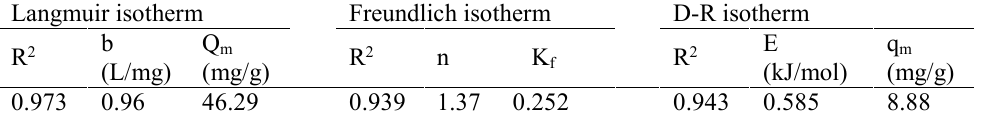
Table1. Langmuir, Freundlich and D-R isotherm parameters for the adsorption of lead by MBAS Langmuir isotherm Freundlich